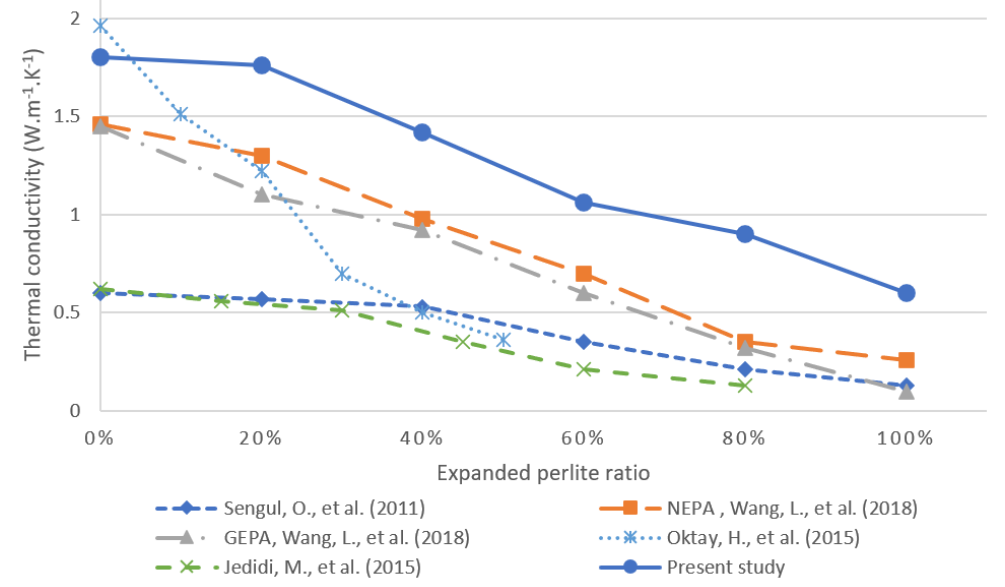
Figure 13. Comparison of the results of the present study and those in the literature regarding thermal conductivity as a function of the volumetric fraction of incorporated EP